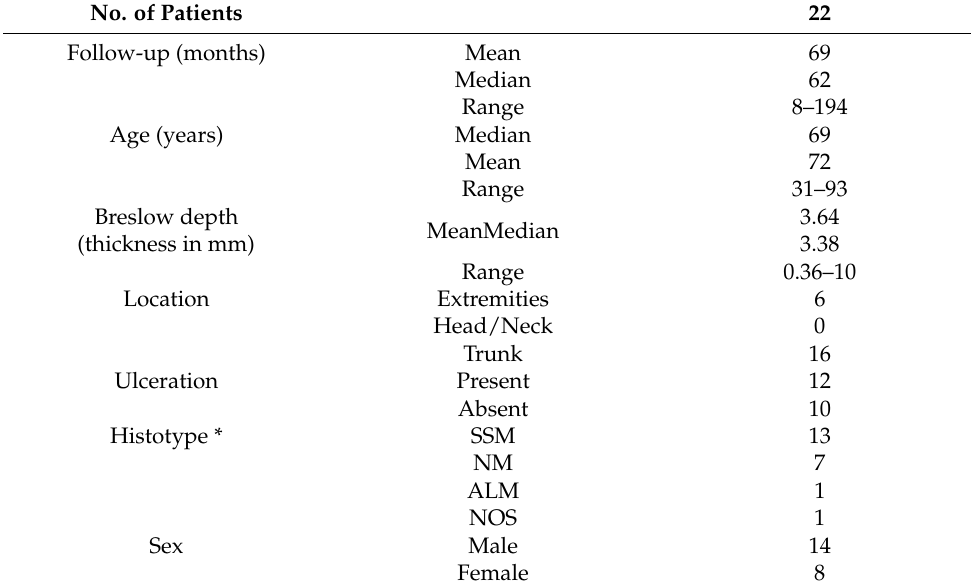
Table 1. Clinicopathologic summary of melanoma patients with primary tumors without subse- quent metastasis.